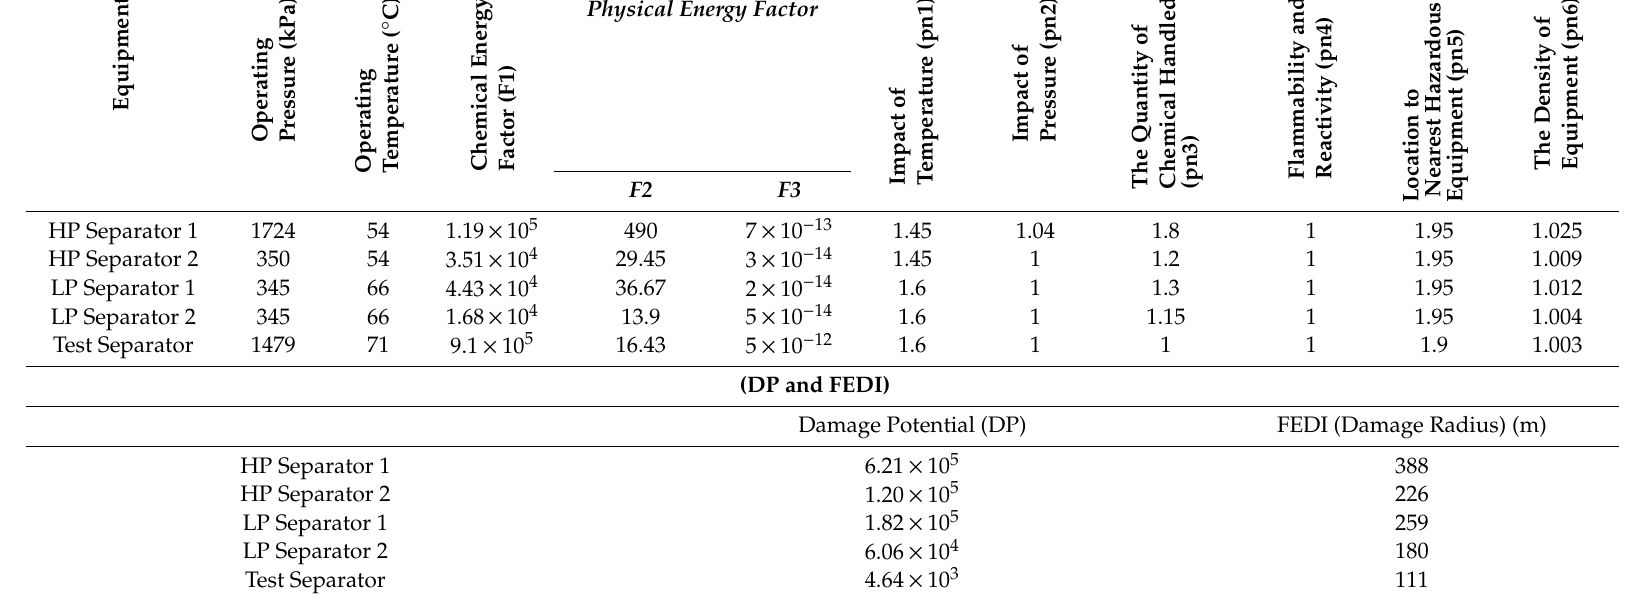
Table 4. Hazard identification of separators using